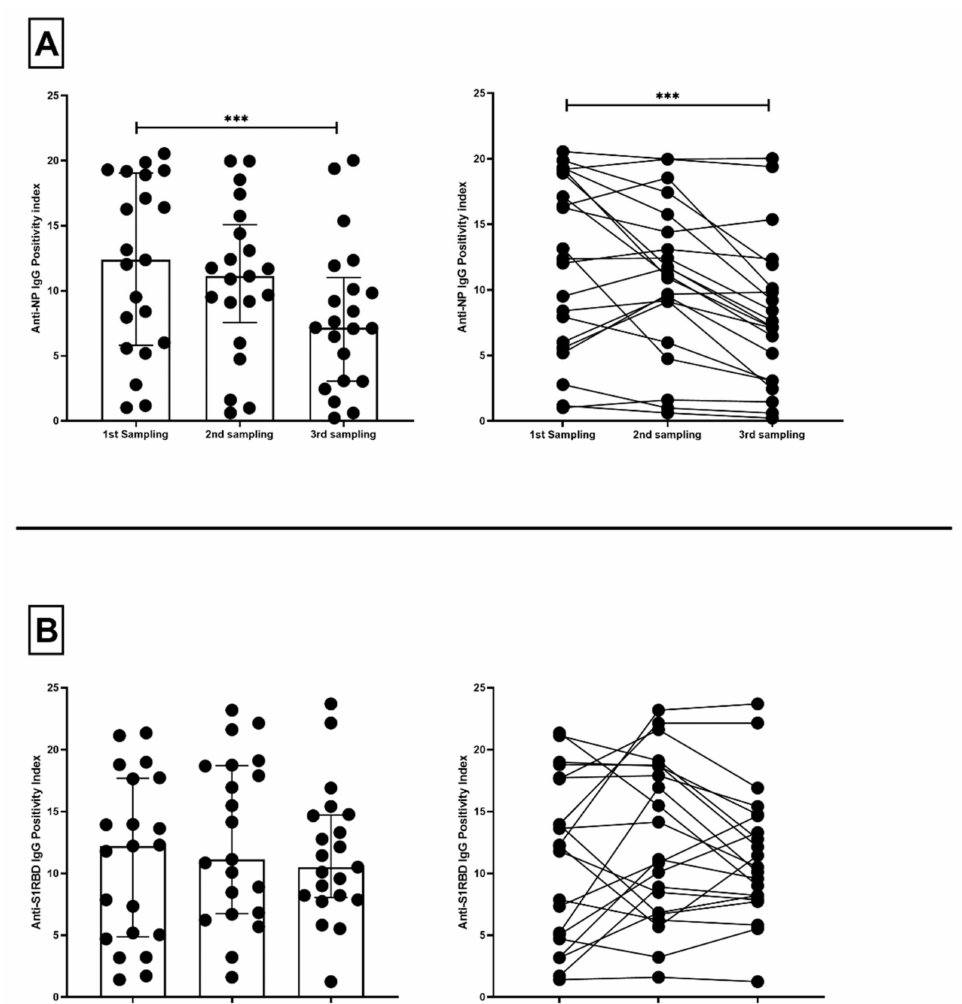
Figure 4. Distribution ( left ) and correlation graph ( right ) of positivity index (P.I.) of ( A ) anti-NP IgG and ( B ) anti-S1RBD IgG antibodies across 3 sampling points of antibody-positive volunteers ( n = 21). Bars represent median and interquartile ranges. *** p <